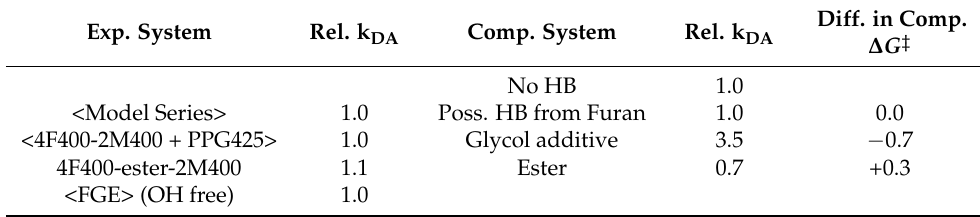
Table 6. Experimental versus computed relative total Diels–Alder reaction rate constants k DA at 20 ◦ C, using k DA of the average of the Model Series experimental systems or the “No HB” computational system as a reference. Difference in computed ∆ G ‡ with respect to the “No HB” system is given in kcal mol − 1 . Diff. in Comp. Exp. System Rel. k DA Comp. System Rel. k DA ∆ G ‡ No HB 1.0 <Model Series> 1.0 Poss. HB from Furan 1.0 0.0 <4F400-2M400 + PPG425> 1.0 Glycol additive 3.5 −